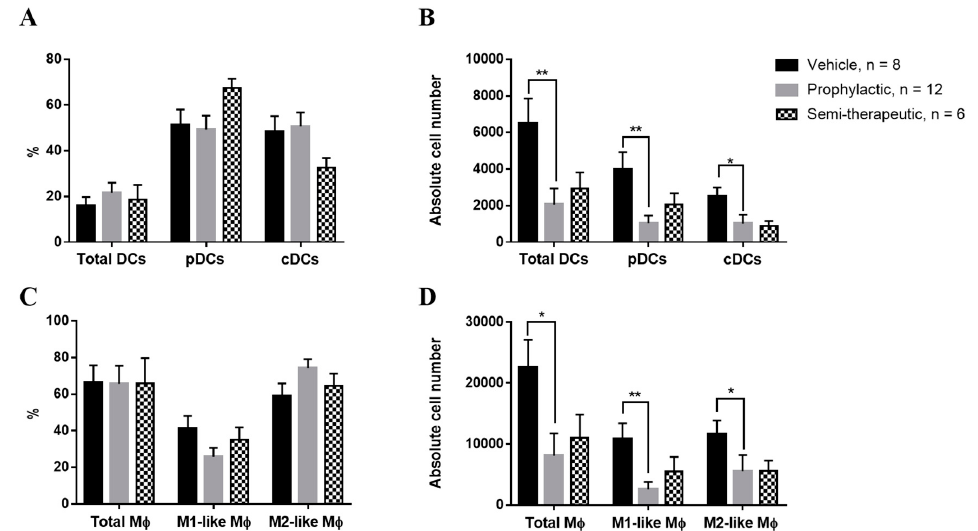
Figure 6. GLP-1 RA dulaglutide administration markedly decreases the numbers of dendritic cells (DCs) and macrophages in the CNS parenchyma of EAE mice. Percentages ( A and C ) and absolute numbers ( B and D ) of dendritic cell (DC) ( A and B ) and macrophage (M ψ ) ( C and D ) populations in